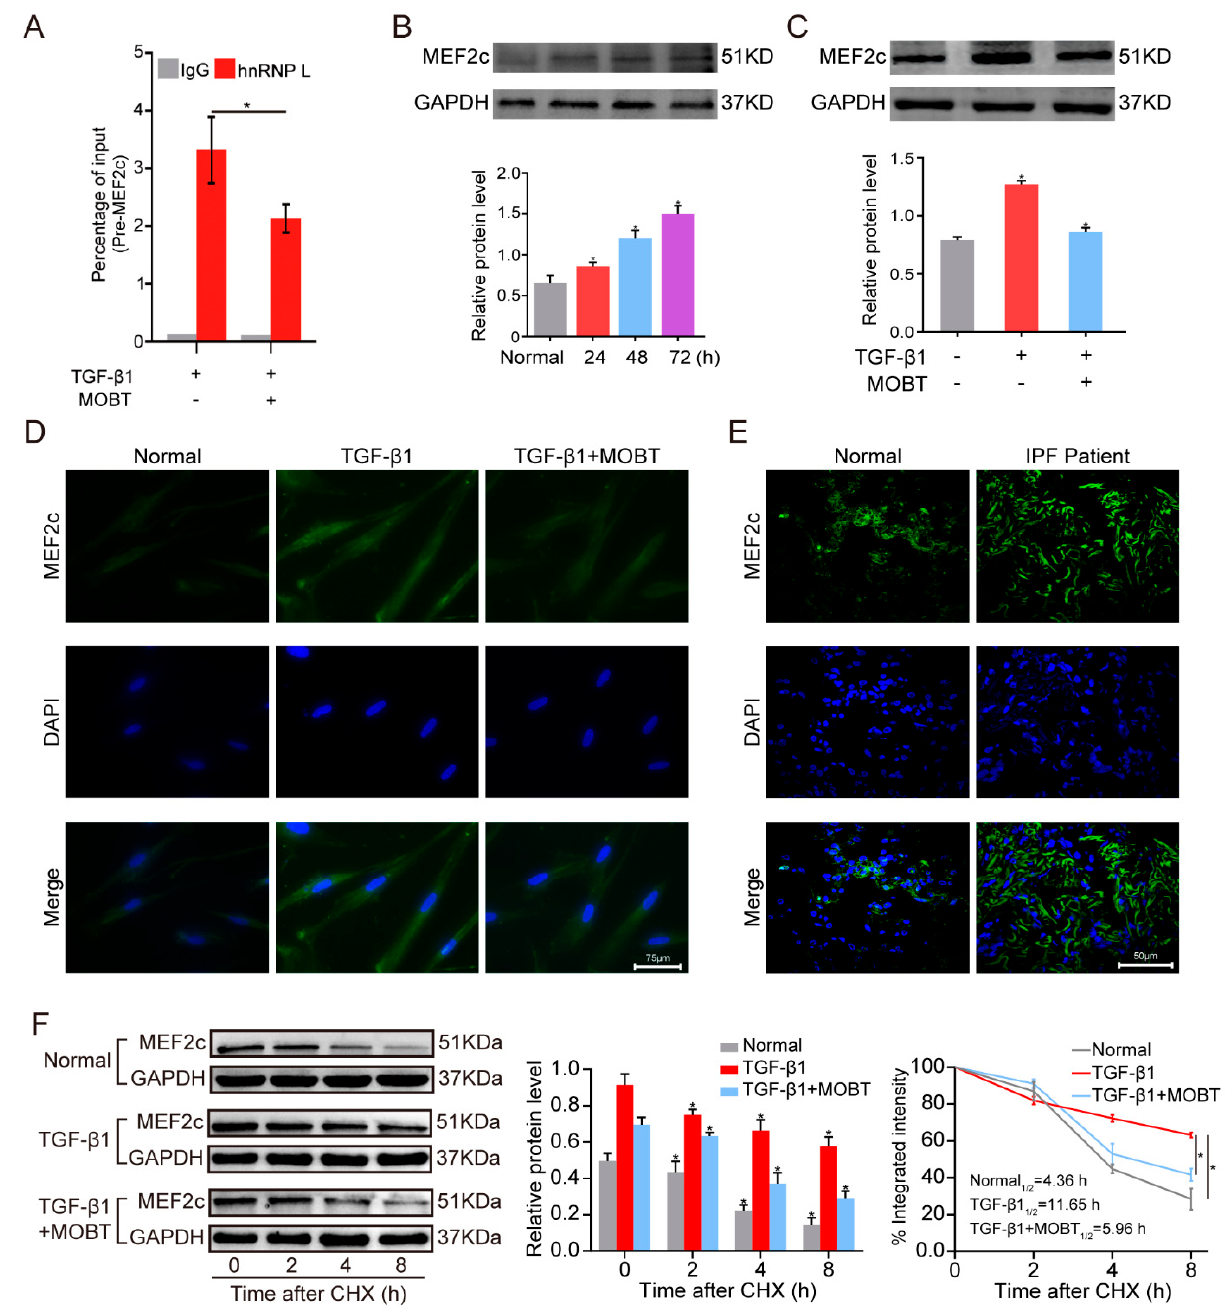
Figure 4. MOBT blocked lung fibrogenesis via inhibiting MEF2c stability. ( A ) The RIP assay showed that MOBT reduced the combination of pre-mMEF2c with hnRNP L. IgG was used as a control. ( B ) The Western blot analysis revealed that MEF2c expression increased in the TGF- β 1-treated cells for different time points. ( C ) The Western blot analysis showed that 10 µ g/mL MOBT decreased the MEF2c expression. ( D ) The immunofluorescence result demonstrated that the TGF- β 1 group expressed abundant MEF2c compared with the normal group, whereas the TGF- β 1 + MOBT group decreased the MEF2c expression. The green color indicates MEF2c. The blue color indicates the nucleus. ( E ) The immunofluorescence images showed that the MEF2c expression increased in IPF patient’s lung tissues compared with the normal tissue adjacent to lung cancer. The green color indicates MEF2c. The blue color indicates the nucleus. ( F ) Stability testing showed that MEF2c stability was promoted by TGF- β 1 and decreased by MOBT treatment. The half-life in each group was 4.36, 11.65, and 5.96 h in the normal, TGF- β 1, and TGF- β 1 + MOBT groups, respectively. Each bar represents mean ± SD, * p < 0.05.